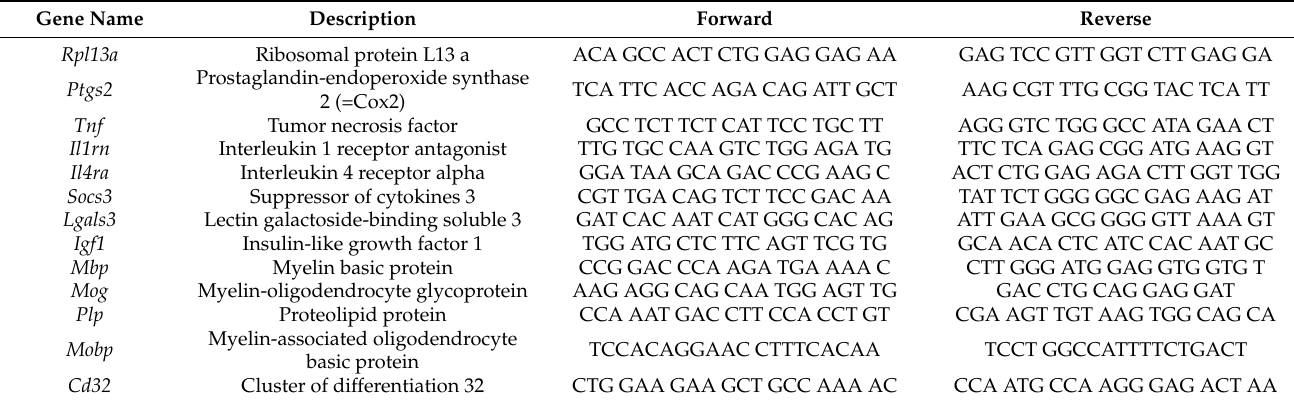
Table 1. Primer sequences for RT-qPCR